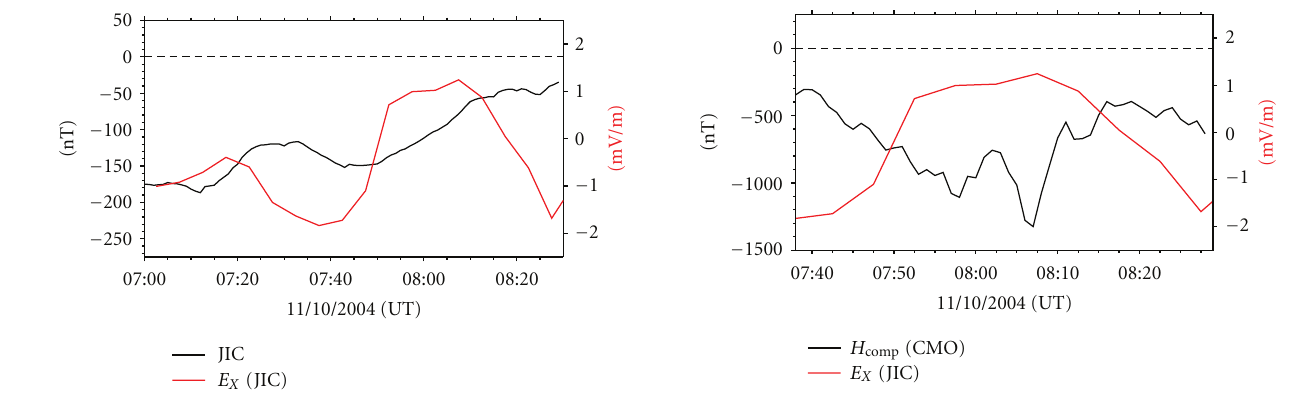
Figure 5: The electric and magnetic field time-series, 90 degrees out of phase over Jicamarca, Peru.